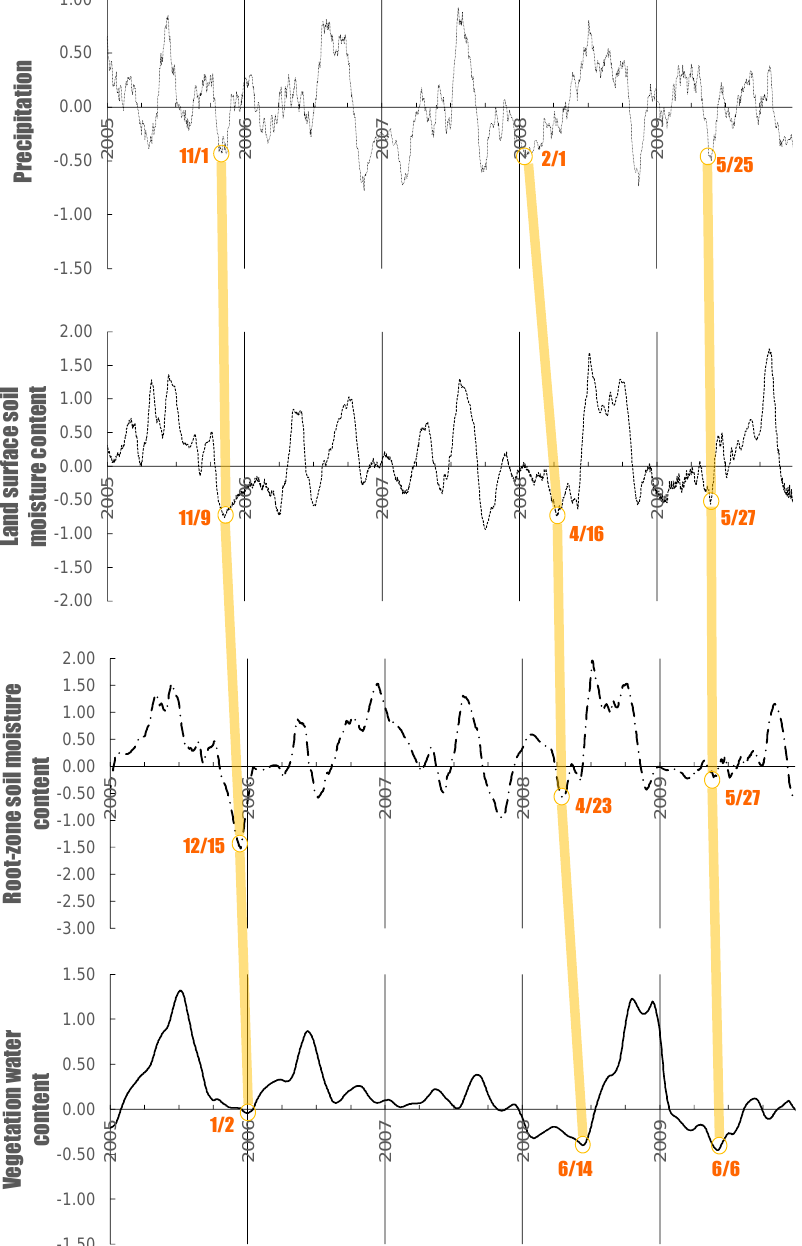
Figure 8. Normalized index ( NI i ) for precipitation and ecohydrological variables in the first half of the agricultural drought evaluation period (2005–2009). Spatial averages for the Sahel-inland region. From the top, the graphs present precipitation, near-surface soil moisture content, root-zone soil moisture content, and vegetation water content. Dates in orange indicate the middle day of each negative peak period. We found that each peak had a time lag when focusing on the negative peak for precipitation, soil moisture content, and vegetation water content, as shown by the yellow marks and